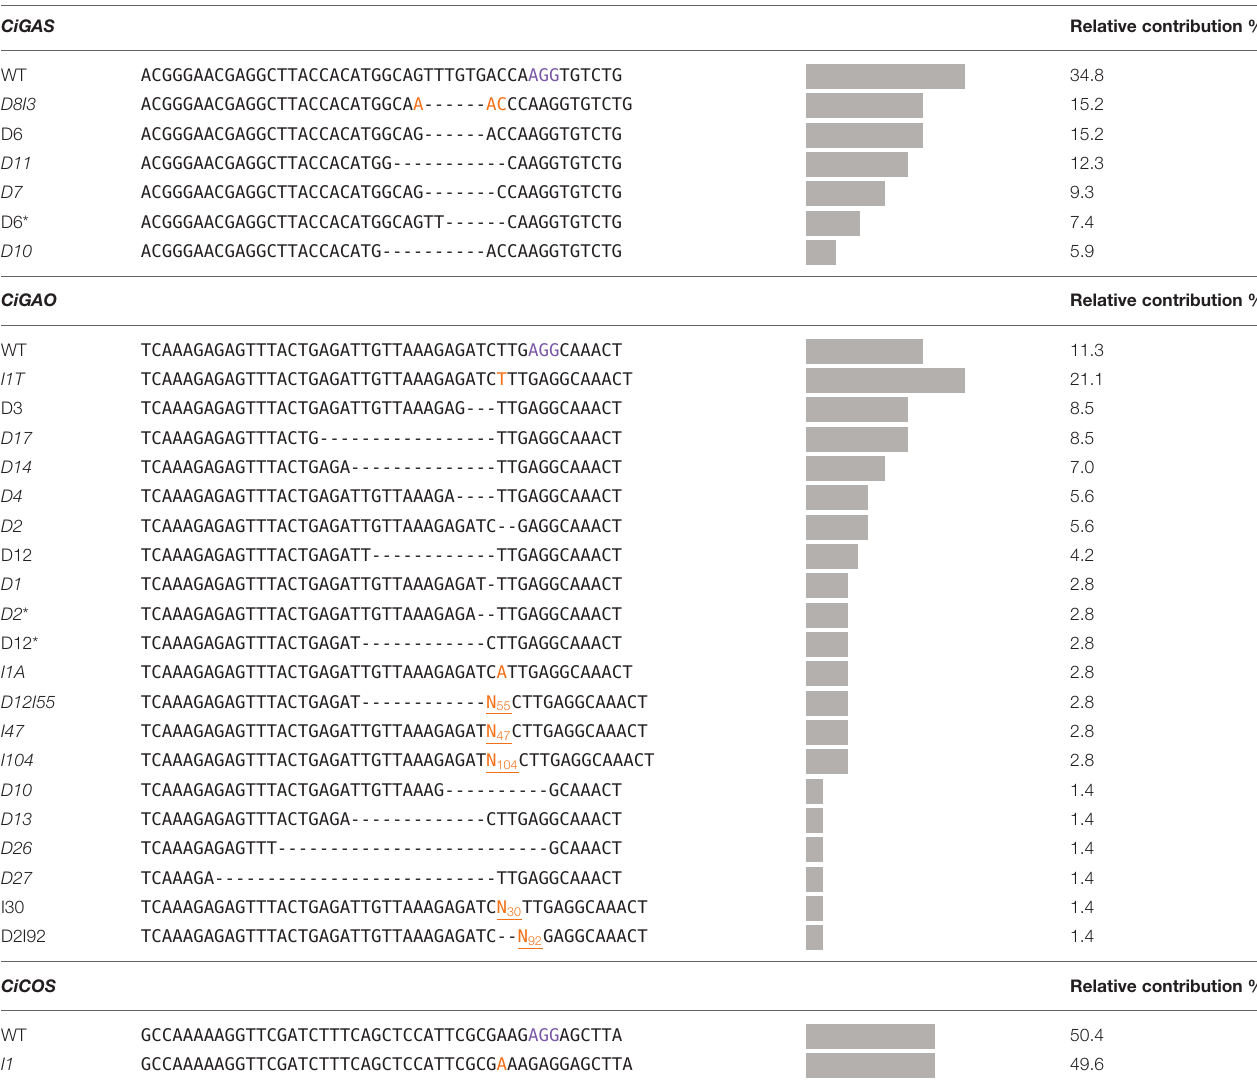
TABLE 7 | Overview of the mutation types and relative contribution of each mutation type in the plants transfected with pCDB-Cas9 vector targeting CiGAS , CiGAO , and CiCOS .